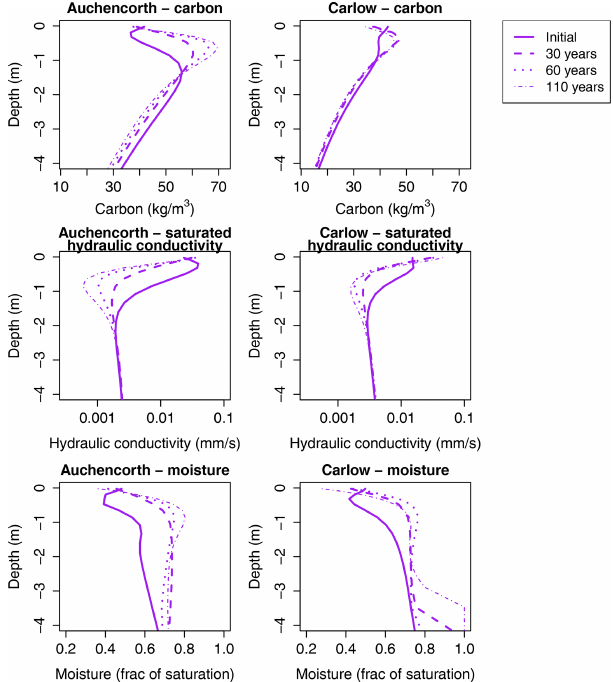
Figure 9. Response of the soil profile following drainage in JULES-